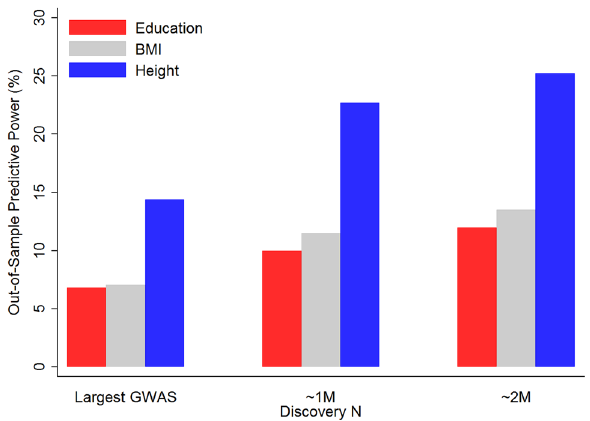
Fig. 3 Predictive power of future PGSs. Currently attainable predictive power of PGSs ( “ Largest GWAS ” ) and projected explana- tory power of future PGSs derived from discovery samples of 1M and 2M individuals ( “ ~1M ” and “ ~2M ” ). For each trait, we calculate h 2 directly from Eq. 3. We assume M = 70,000, and using values of SNP R 2 and N from the largest published GWAS of the trait (e.g., 6.9% and 405,000 for education). Implied SNP-based heritabilities are 15, 16 and 30%, respectively. Parameterizations based on estimates of SNP- based heritabilities (25, 25 and 50%) yield higher